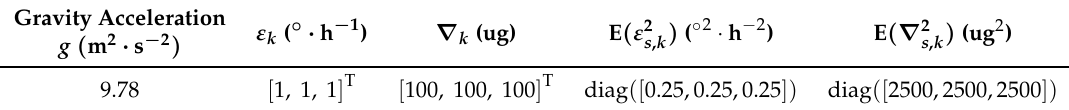
Table 3. Parameters of Inertial Navigation System (INS) output.